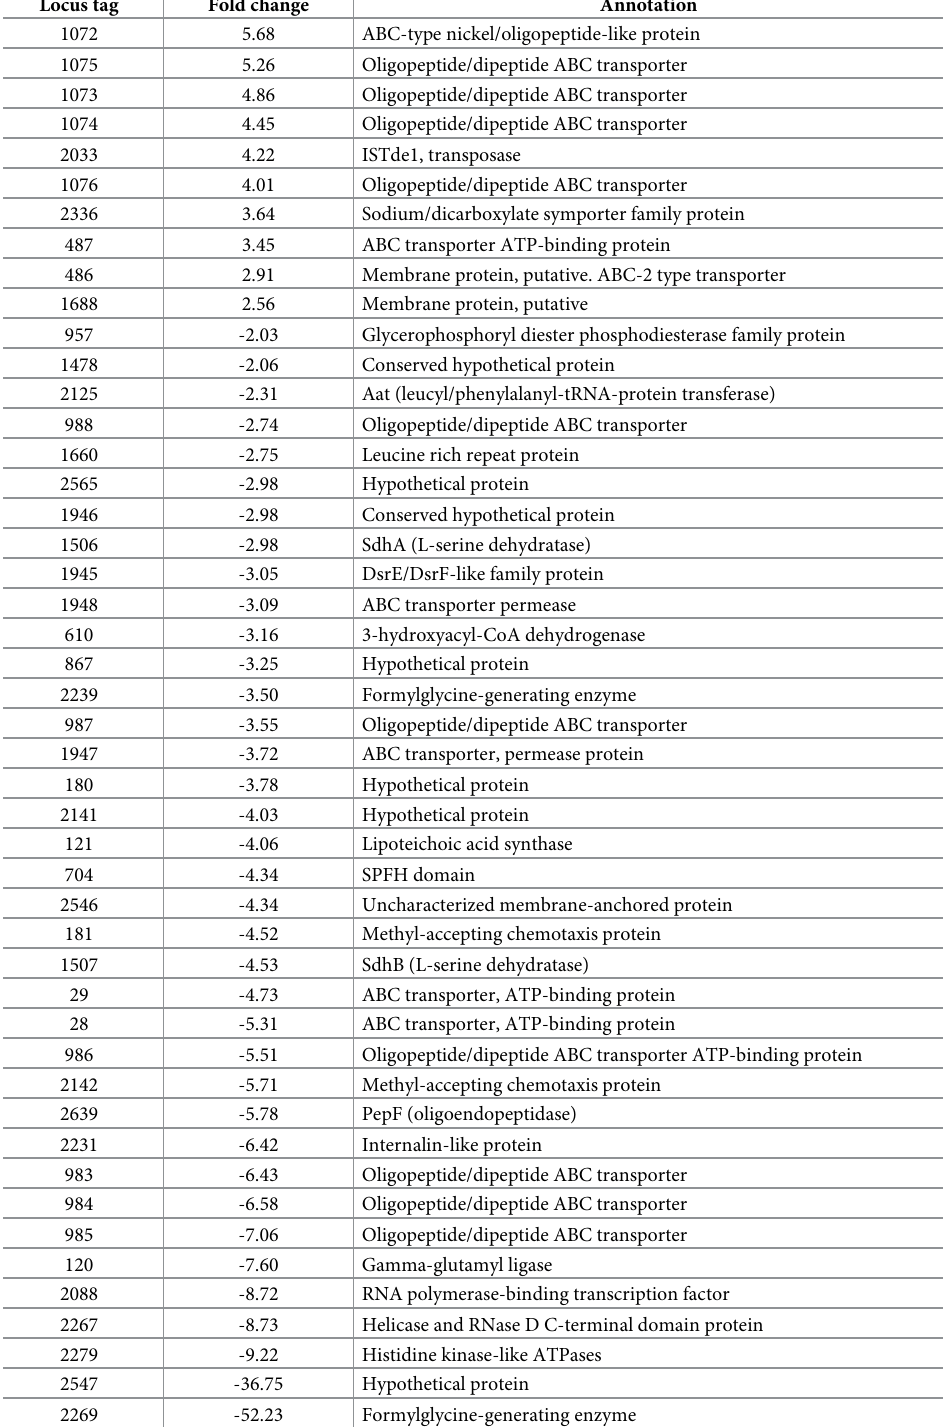
Table 4. Genes with significantly different transcriptional activity between the original and mutant